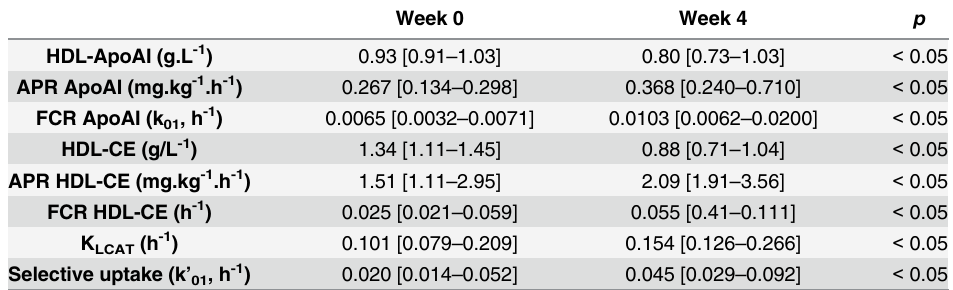
Table 3. Kinetic parameters of HDL apolipoprotein AI and HDL-cholesteryl ester before (week 0) and after 4 weeks of NA treatment (week 4) identified using models of Fig 1. FCR, fractional catabolic rate; APR, absolute production rate; HDL-UC, HDL unesterified cholesterol concentration; HDL-CE, HDL choles- teryl ester concentration; K LCAT , cholesterol esterification rate by LCAT. Data are expressed as median [mini- mum-maximum], n =